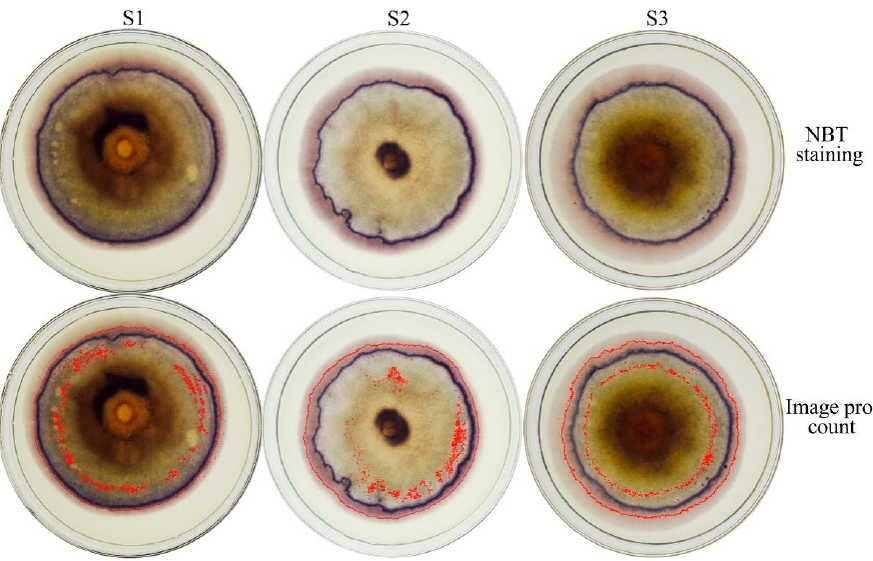
Figure 2. NBT staining photos of colony superoxide anion. The upper row is the shoot in the back light, and the lower row is the Image-pro software count picture. S1 group ( n = 3): inoculation of F. solani on normal PDA; S2 group ( n = 3): inoculation of F. solani on PDA containing 40 µmol/L DPI; S3 group ( n = 3): inoculation of F. solani on PDA containing 40 µmol/L DPI. On the fourth day of cultivation, 5 mL of 0.0012% H 2 O 2 was added to every dish.